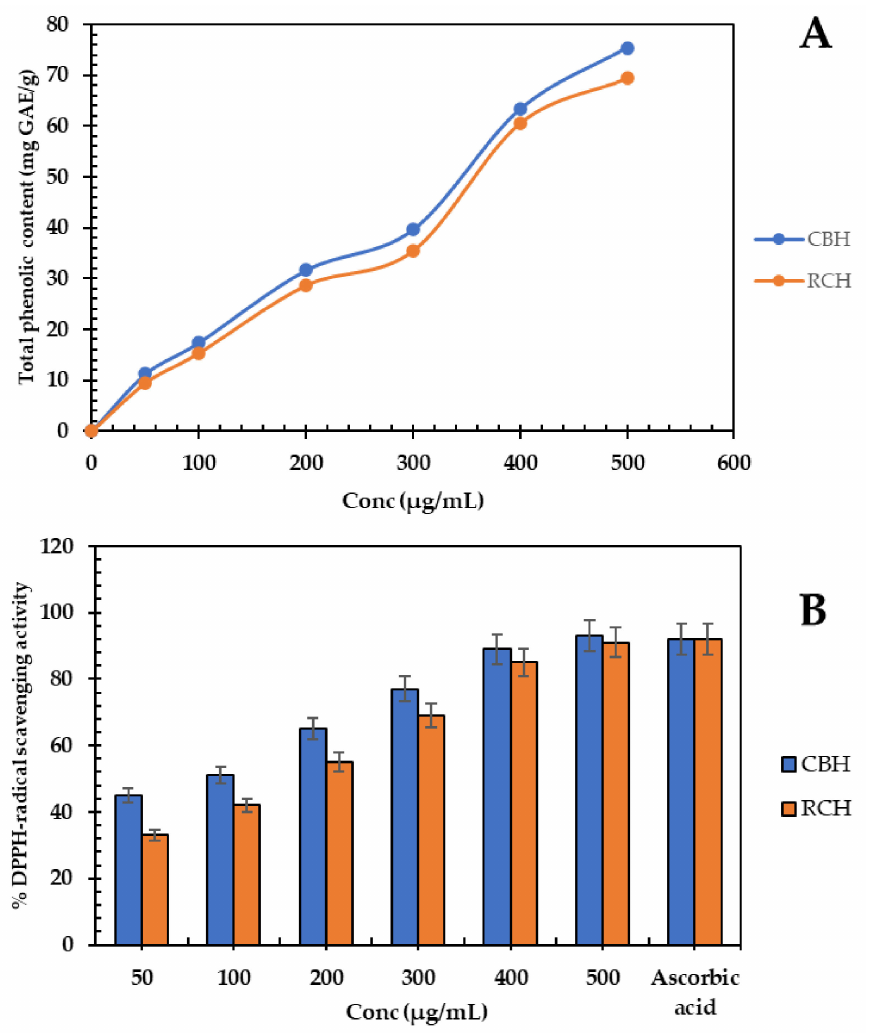
Figure 3. ( A ), Total phenolic content (mg gallic acid equivalent/g) of CBH and RCH concentrations (50–500 µ g/mL). ( B ), DPPH˙ scavenging activity of CBH and RCH concentrations compared to ascorbic acid (500 µ